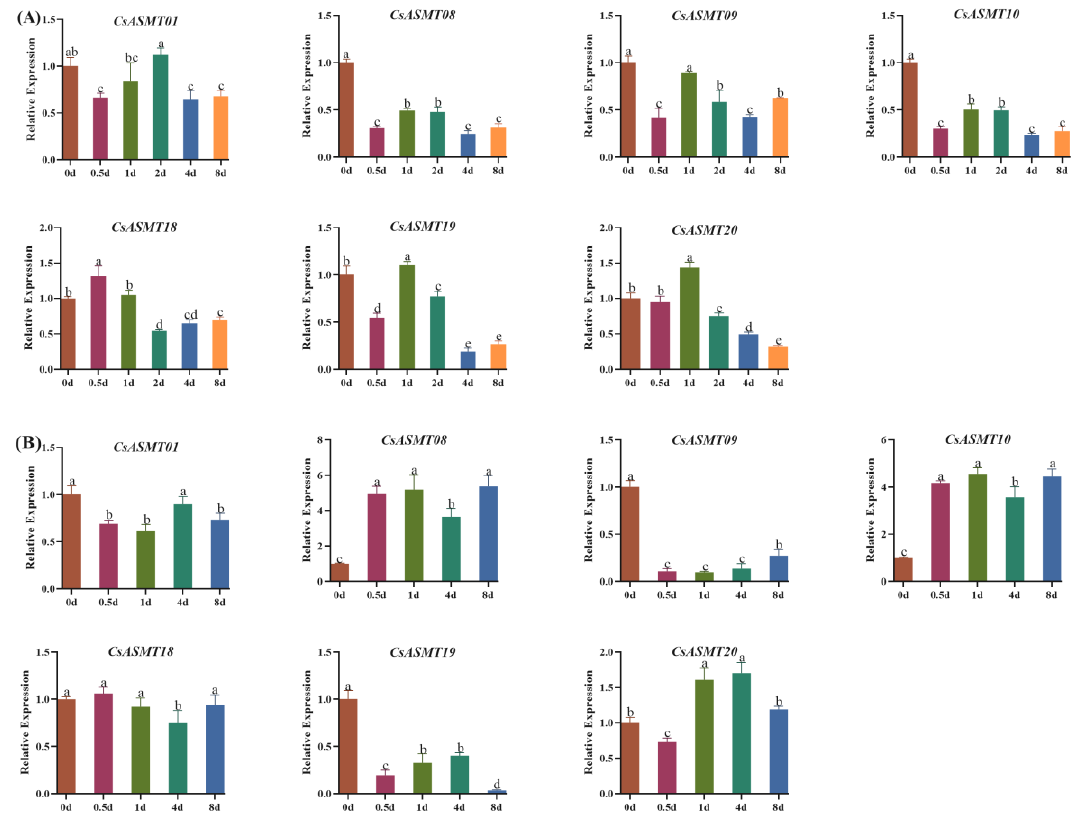
Figure 9. ( A ) qRT-PCR of 7 selected C. sinensis ASMT genes in response to drought stress; ( B ) qRT- PCR of 7 selected C. sinensis ASMT genes in response to cold stress. Bars represent the mean ± standard deviation of three replicates, different letters indicate significant differences at different time points, and all data were subjected to one-way ANOVA and LSD test ( p < 0.05).